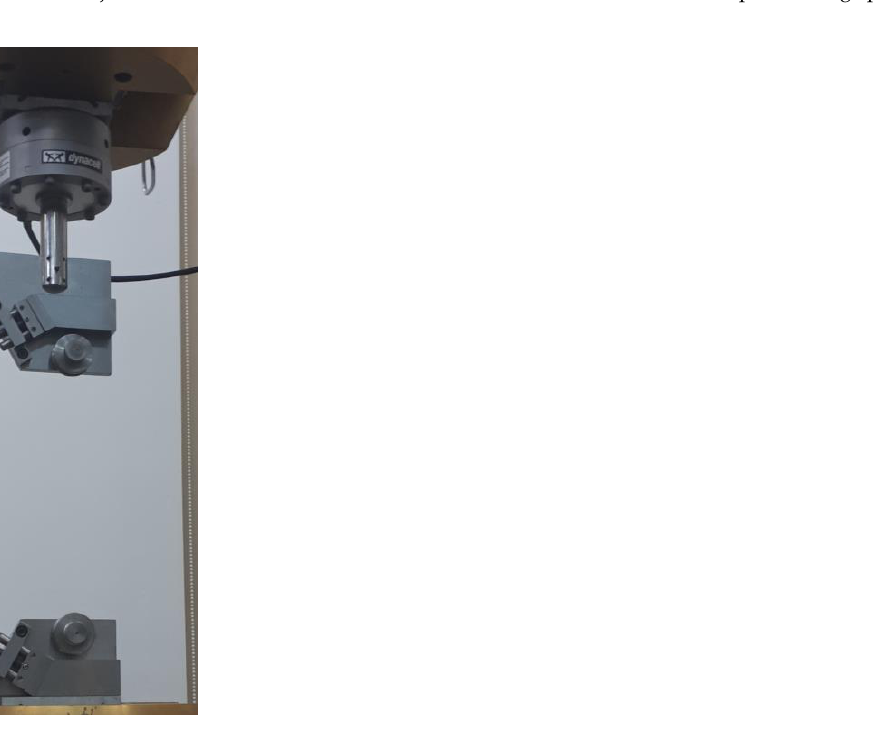
Figure 4. Thread grips installed in the hydraulic clamps of the testing machine with an additionally installed force precise measuring head.